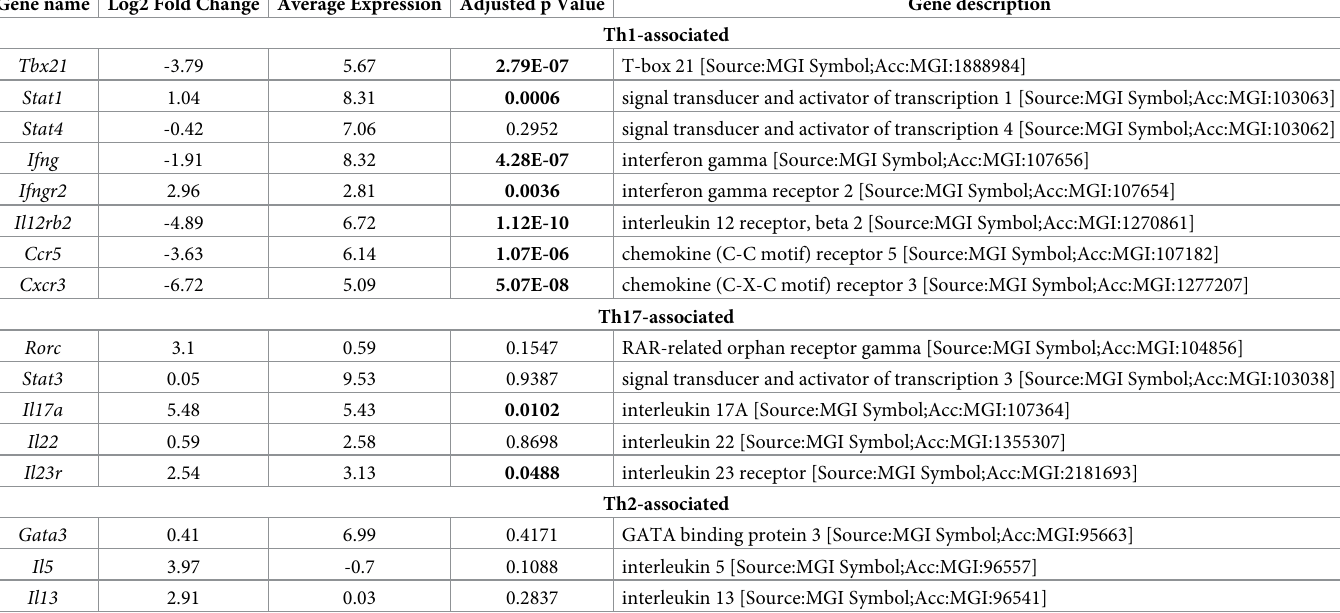
Table 1. Selected gene expression analysis of Tbx21 -deficient CD4+ T cells compared to wild-type. CD4+ T cells were FACS sorted from FRTs 17 days post infection and processed for bulk RNA sequencing. Table shows differential gene expression analysis of selected markers for Th1, Th2 and Th17 responses in Tbx21-/- samples com- pared to wild-type. p < 0.05 are shown in bold. Average expression is across all samples in log2 counts per million reads. Adjusted p-value is adjusted with the Benjamini- Hochberg false discovery rate.